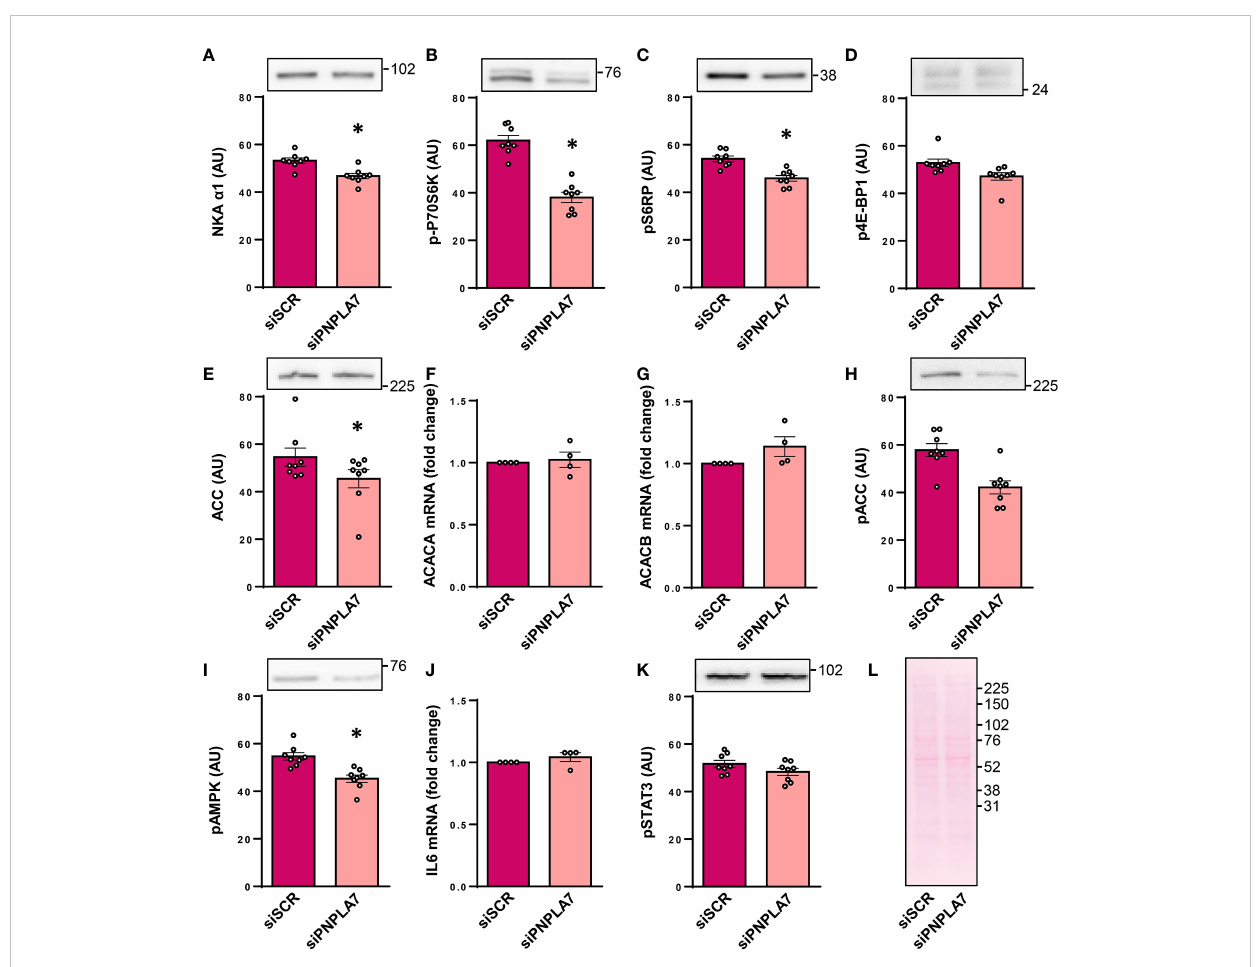
FIGURE 2 Functional assessment of PNPLA7 in cultured human myoblasts. Myoblasts were treated with siRNA against PNPLA7 mRNA (siPNPLA7) or scrambled siRNA (siSCR). Functional consequences of PNPLA7 knock-down (A – K) were estimated by measuring (A) the abundance of a 1-subunit of Na + ,K + - ATPase (NKA a 1), (B) phosphorylation of p70S6K Thr389 , (C) phosphorylation of S6RP Ser235/236 , (D) phosphorylation of 4E-BP1 Thr 37/46 , (E) the abundance of ACC, (F) ACC1 mRNA (gene ACACA ), (G) ACC2 mRNA (gene ACACB ), (H) phosphorylation of ACC Ser79 , (I) phosphorylation of AMPK Thr172 , (J) IL6 mRNA, and (K) phosphorylation of STAT3 Tyr705 . Ponceau S staining was used as a control of loading and transfer of immunoblotting (A – E, H – K) . (L) A representative Ponceau-stained membrane. Actin blots, which were used as an additional loading control